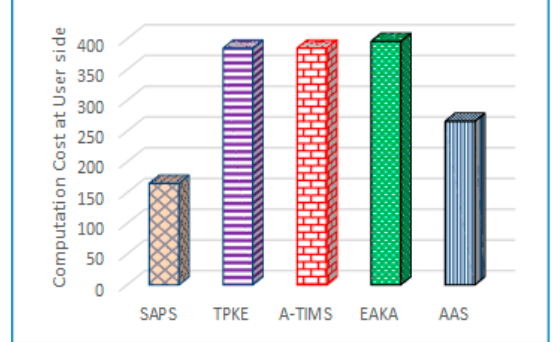
Figure 6. Computation cost at user side.